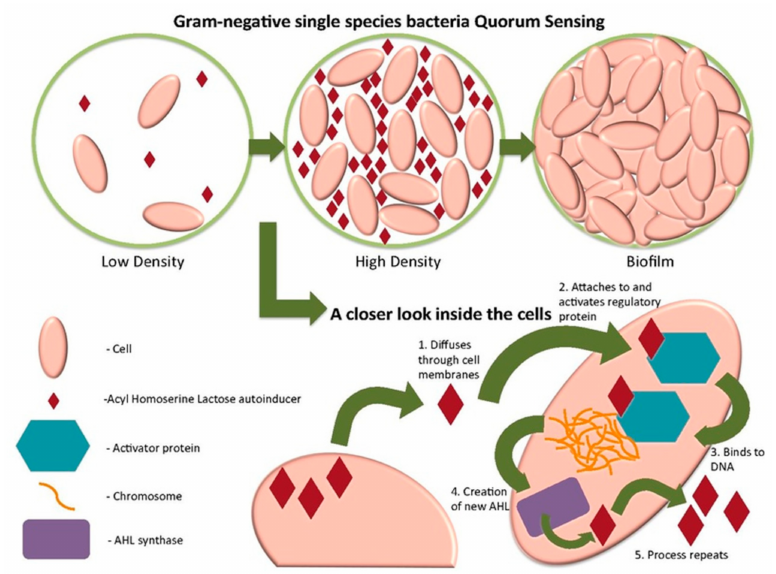
Figure 25. Mechanisms of quorum sensing from isolated bacteria to the formation of biofilms. Early detection of quorum sensing signaling molecules will require action to prevent biofilm formation. https://www.wikiwand.com/en/Quorum_sensing; last accessed 8 June